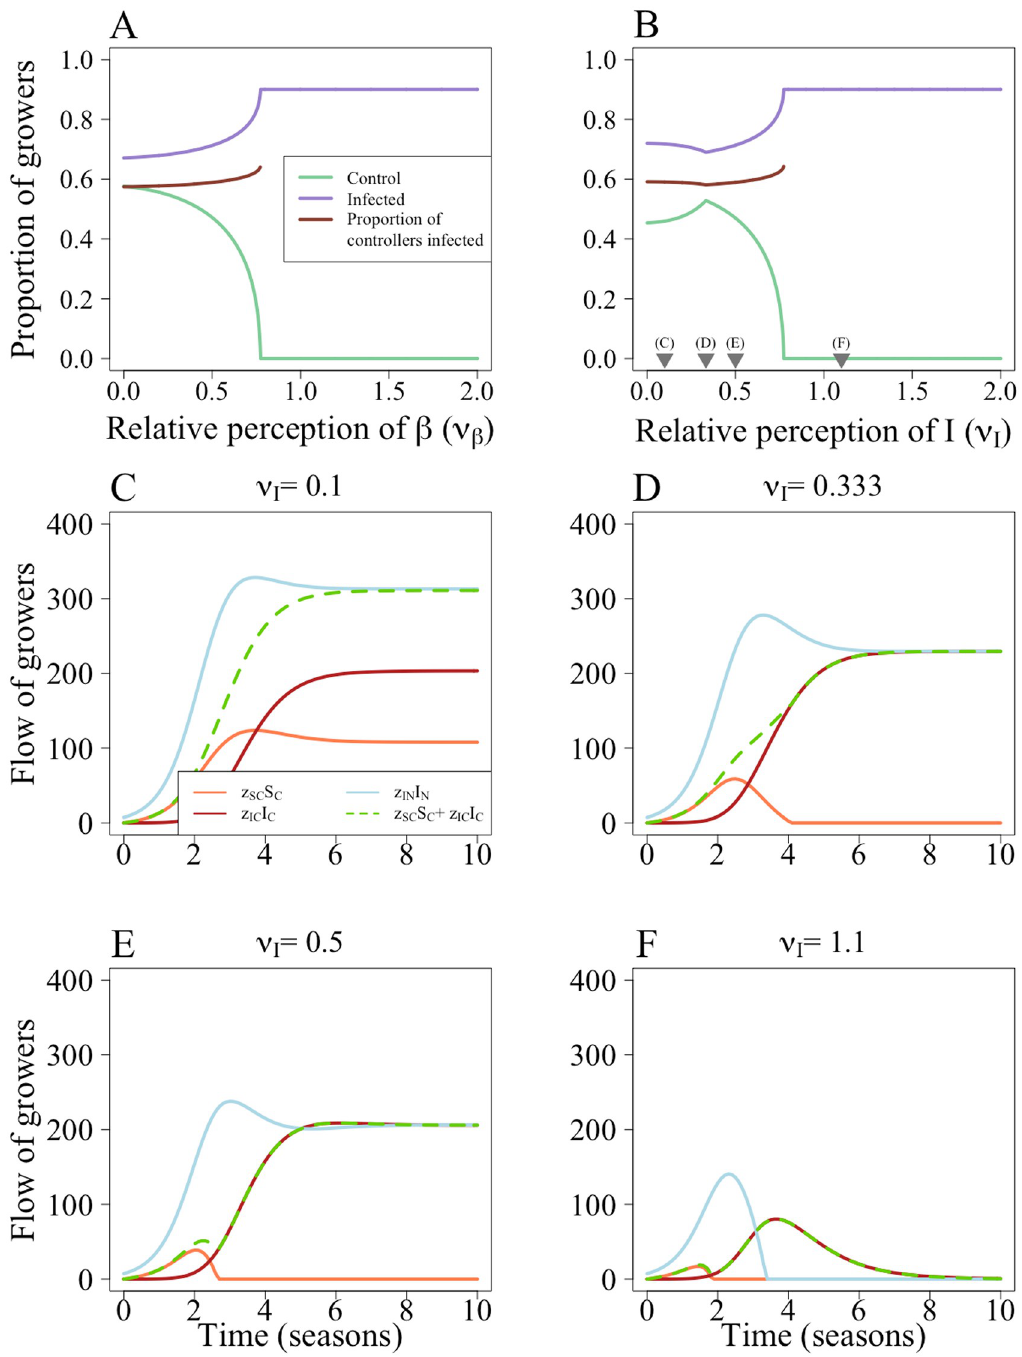
Fig 6. Effect of systematic uncertainty of epidemiological parameters and quantities. When the perception of β ( ν β ) is small there is a higher proportion of controllers A, which decreases as ν β increases. In B, there is initially an increase in the proportion ). In B the number of infected fields levels out once the conditions for a “no control” controlling with the perception of I ( ν I equilibrium are met. The grey triangles in B show the values of ν I used in C-F. C When ν I = 0.1, S C growers still perceive that it is profitable to change strategy ( z SC > 0). D At ν I = 0.33, as the number of infected fields increases, the perceived value of P N ( ~ P ) N decreases and z = 0. However, they continue to get infected and there is an increase in I fields. E At ν = 0.5, S fields stop SC C I C switching strategy earlier in the epidemic. As ~ P falls, so does z . F At ν = 1.1, ~ P < ~ P , so z ¼ 0 . This leads to a “no control” IN I C C IN I N equilibrium. Parameters are as in Table